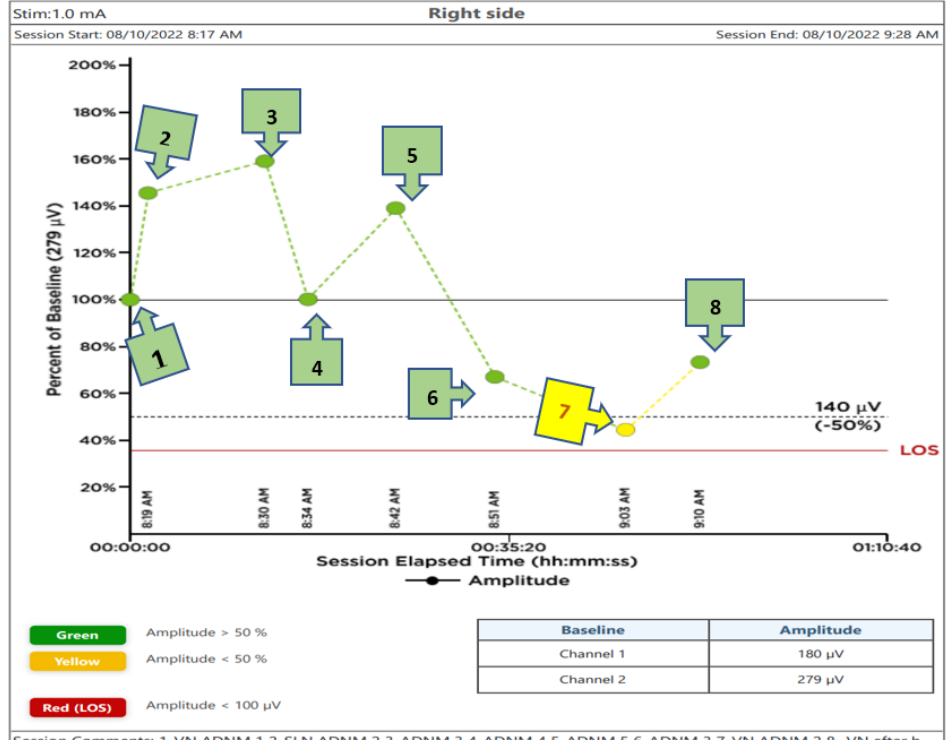
Figure 6. The steps of the Abu Dhabi Neural Mapping (ADNM) diagram during a right-sided hemithyroidectomy, using the intraoperative neuromonitoring system, NIM Vital™, with a stimulation current of 1 mA. Here, the number indicates the following signals: 1. Vagal nerve pre-dissection below the crossing point of RLN, with ITA as the baseline EMG-amplitude and without any manipulation of the thyroid (ADNM − VN1). 2. EMG-amplitude of an SLN pre-dissection at the level of upper pole vessel division (ADNM − SLN1). 3. EMG-amplitude of an RLN pre-dissection below-crossing with ITA (ADNM-RLN1). 4. EMG-amplitude of an RLN pre-dissection above-crossing with ITA (ADNM − RLN2). 5. EMG-amplitude of RLN pre-dissection at the berry ligament (ADNM − RLN3). 6. EMG-amplitude RLN post-dissection below-crossing with ITA (ADNM − RLN4). 7. EMG-amplitude of VN post-dissection at the level of the larynx incisura, which is below 50% of the baseline (ADNM − VN2). 8. EMG-amplitude after 200 mg hydrocortisone i.v. and, after cooling for 5 min, recovery of EMG-amplitude (ADNM − VN2 recovery). Green points represent EMG amplitude above 50% of the baseline pre-dissection; yellow points were used for EMG amplitude between 50 and 20% of the baseline pre-dissection; red points indicate an EMG-amplitude below 20% of the baseline pre-dissection.